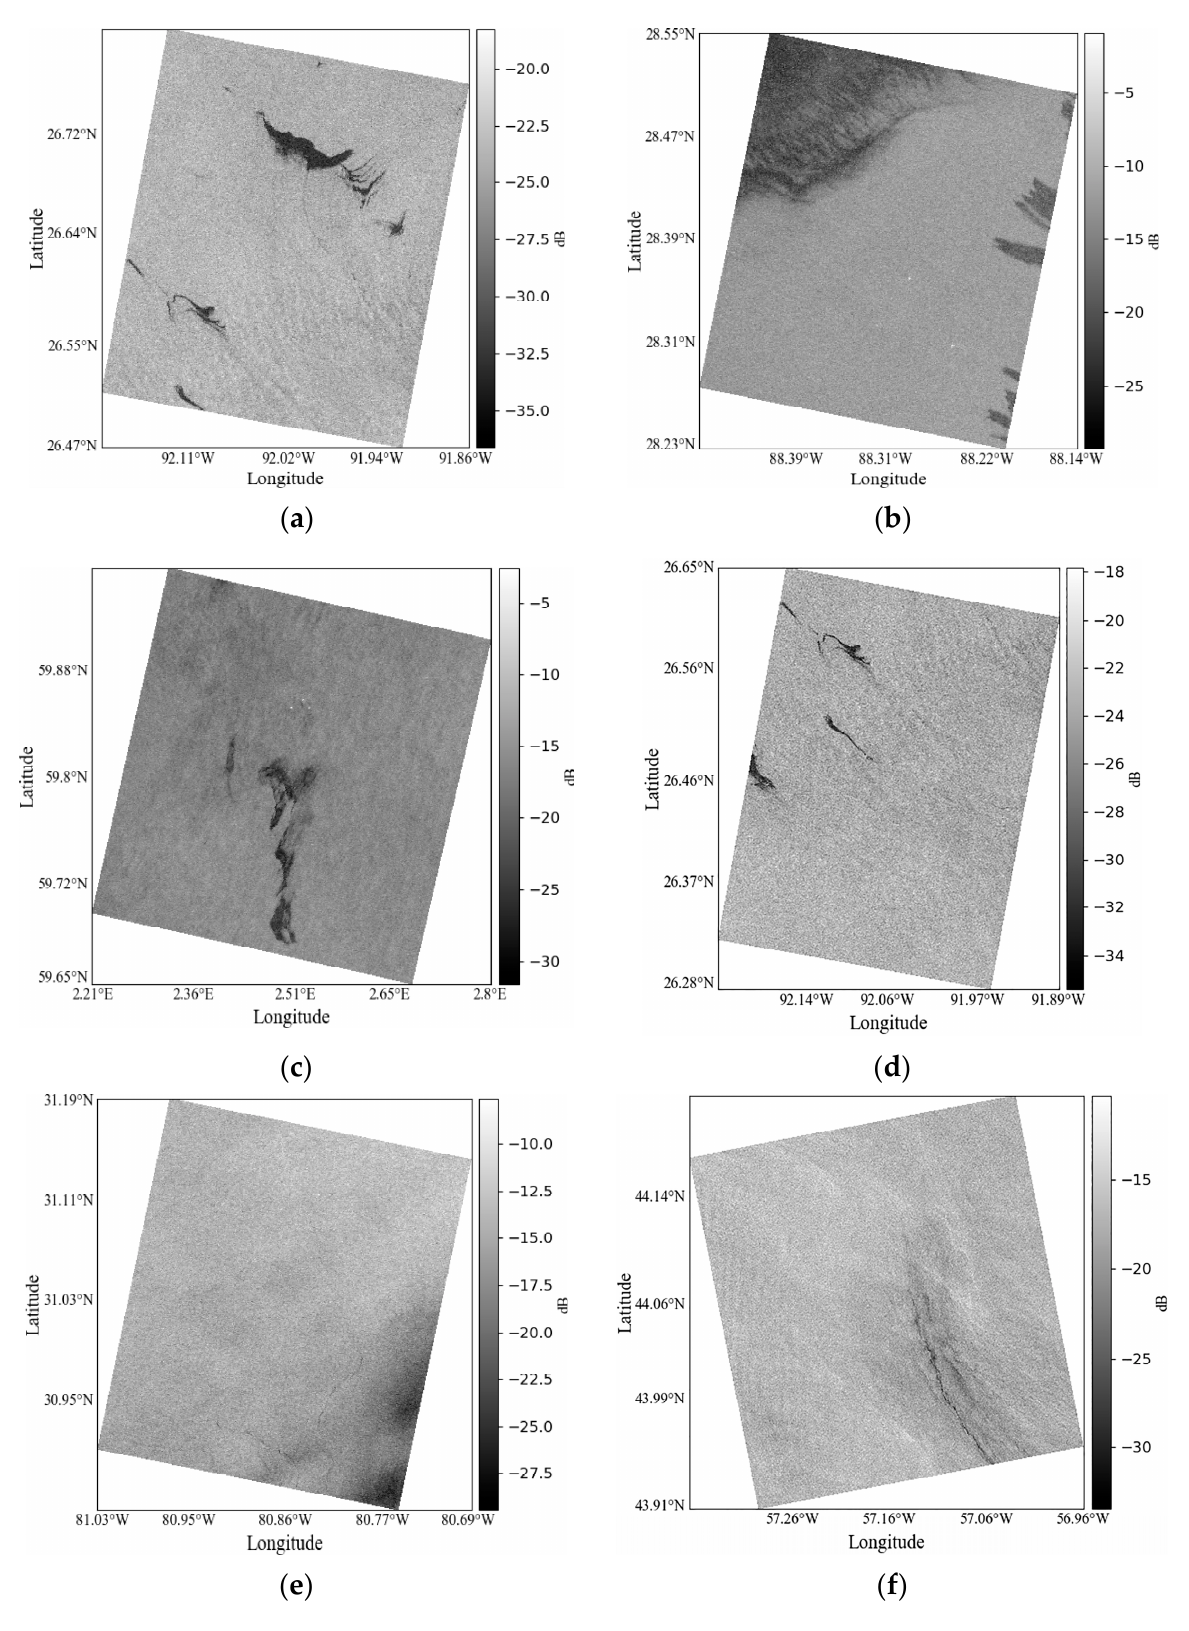
Figure 3. Preprocessed VV polarization images: ( a – d ) are oil spill Cases 1–4, respectively; ( e , f ) are low wind area Cases 5 and 6, respectively. RADARSAT-2 data MacDonald, Dettwiler, and Associates, Ltd., all rights reserved.